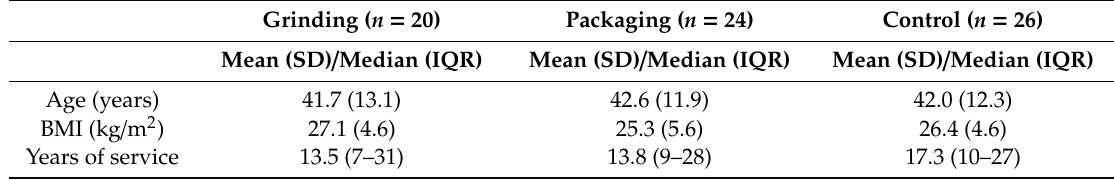
Table 3. Demographic data: continuous